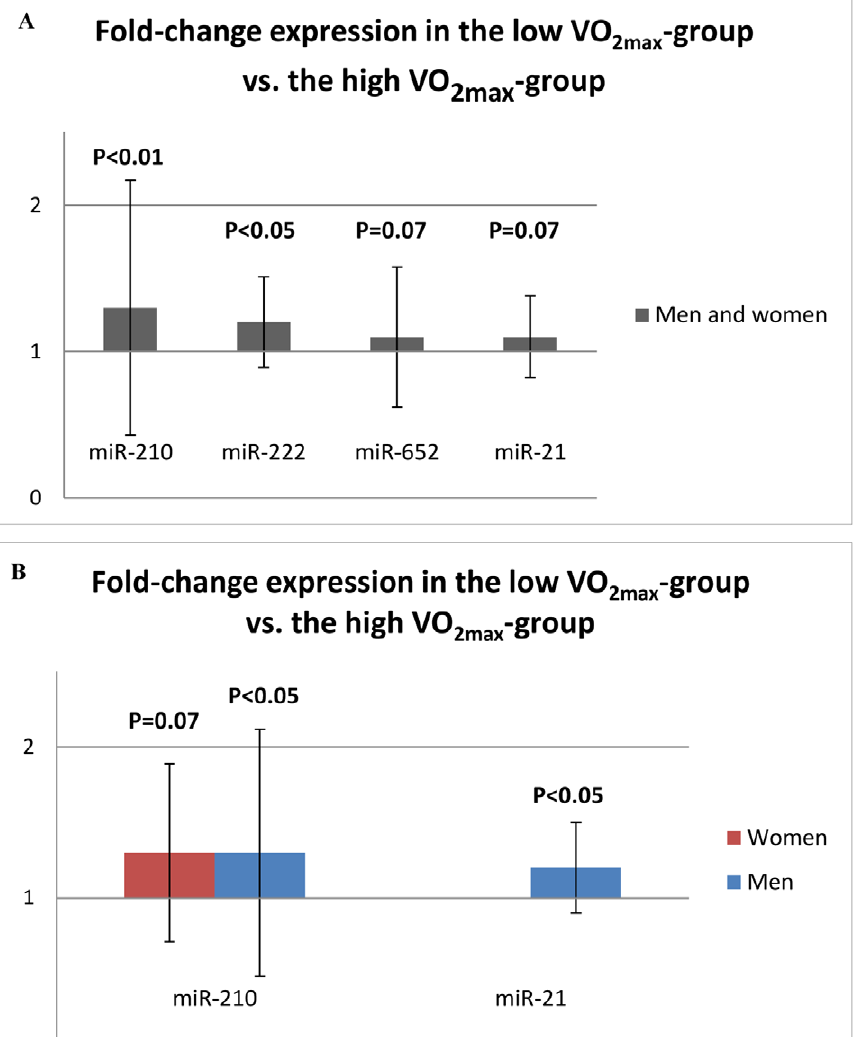
Figure 2. MicroRNAs with significant (or borderline significant) up-regulation in serum samples from subjects with low aerobic fitness compared to subjects with high aerobic fitness. A: In both men and women (n=76), B: Both gender analyzed separately (n=38 men, n=38 women). VO 2max : Maximal oxygen uptake. Error bars represent 1 standard deviation.